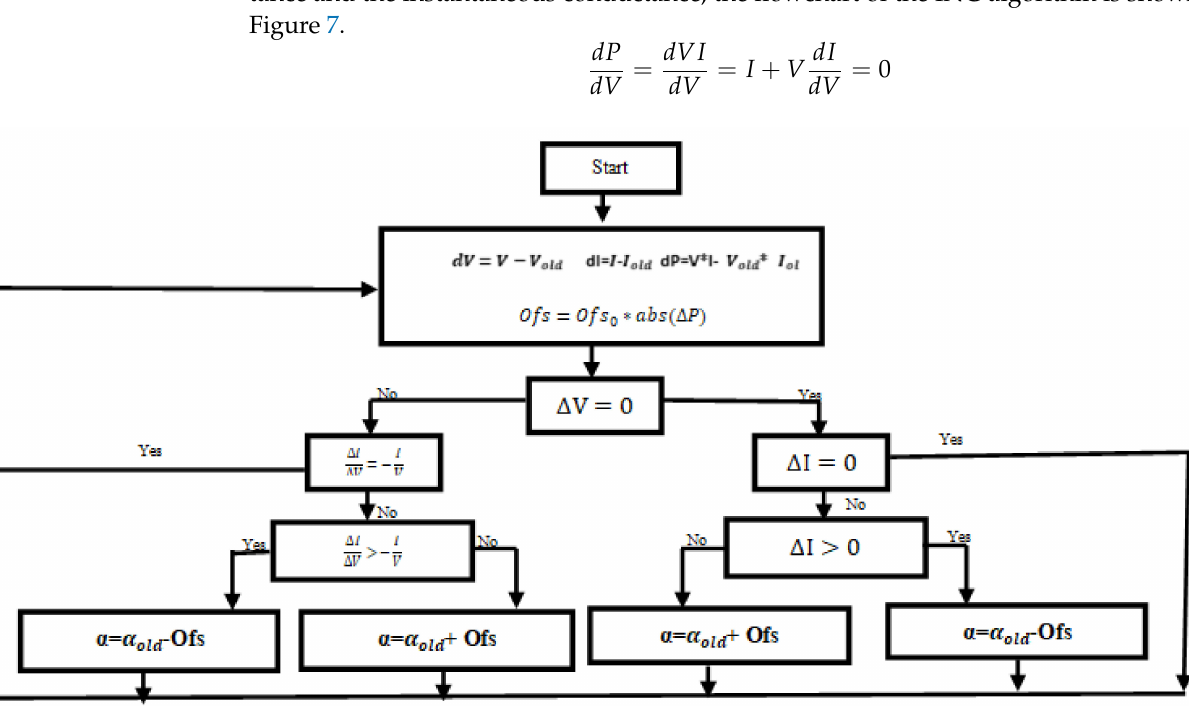
Figure 7. Flowchart of the variable step incremental conductance